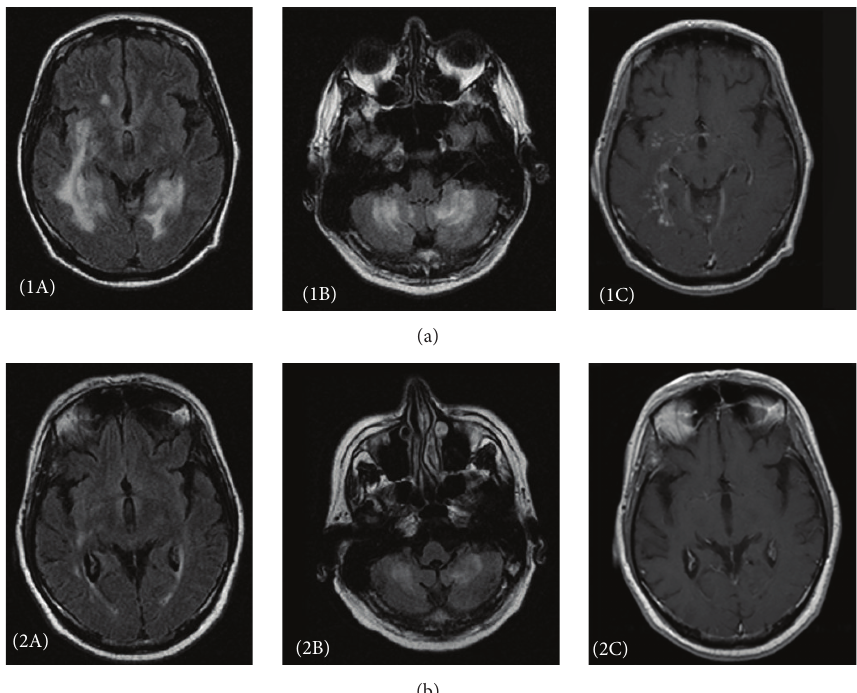
Figure 1: (a) Pretreatment aspects. T2 FLAIR sequences showing disseminated and confluent subcortical hyperintensities within frontoorbital, insular, and internal temporal regions (panel 1A) and cerebellum (panel 1B). Gadolinium injection (panel 1C) reveals nodular enhancement within the same regions and in leptomeningea. ((b) panels 2A, 2B, and 2C) Posttreatment aspects within approximately the same slices, showing an important regression of pathological aspects observed